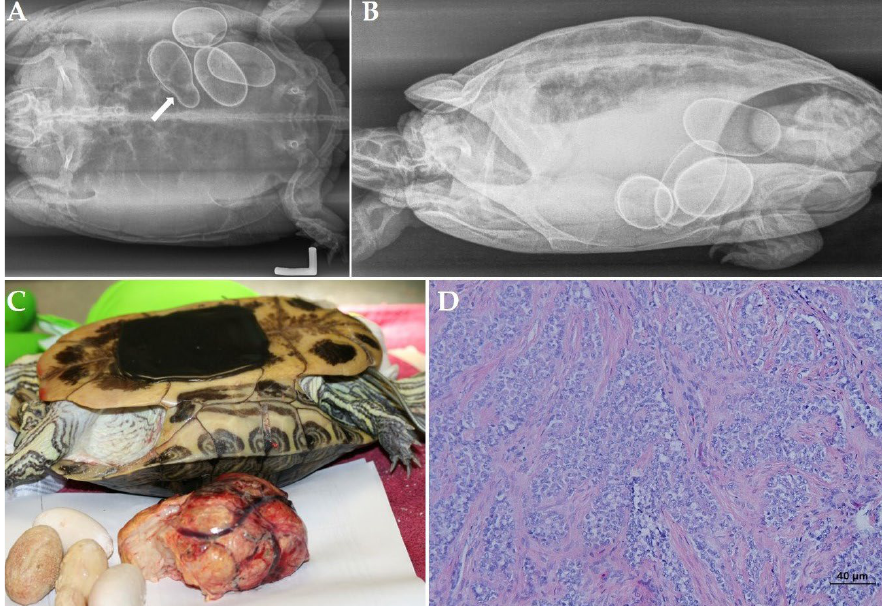
Figure 1. Chronic egg binding associated with a scirrhous ovarian carcinoma in a red-bellied slider ( Trachemys cripta elegans ). ( A ) Dorsoventral radiographic projection: 5 eggs located at the right side of the caudal coelomic cavity. An irregular shape is noted in 3 eggs and all eggs show abnormally thickened shells with a lamellar appearance in the most cranial egg. One egg has an unusual small size and is fused with one of the other eggs (arrow). ( B ) Generalized soft tissue opacity of the coelomic cavity with obvious compression of the lung field on the left laterolateral projection. ( C ) Postoperative view after removal of the ovarian neoplasia and retained eggs. ( D ) Histological section of a scirrhous ovarian carcinoma (Hematoxylin and eosin stain) composed of a cell-rich tissue that is growing infiltrative in dense collagen stroma. Neoplastic cells are organized in islets to multi-layered